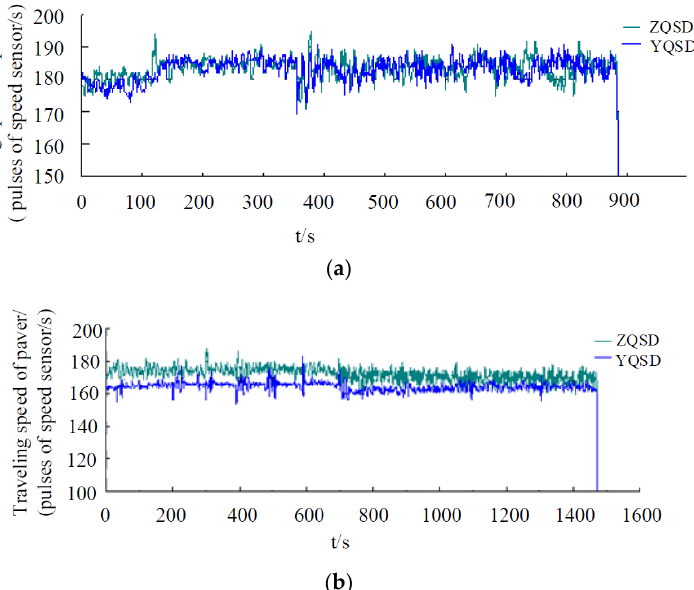
Figure 7. Constant speed test of paver when driving resistance changes. ( a ) Constant speed test of the paver with a new control scheme when driving resistance changes. ( b ) Constant speed test of the paver with the old control scheme when driving resistance changes. ZQSD — Speed of the left wheel, and YQSD — speed of the right wheel.